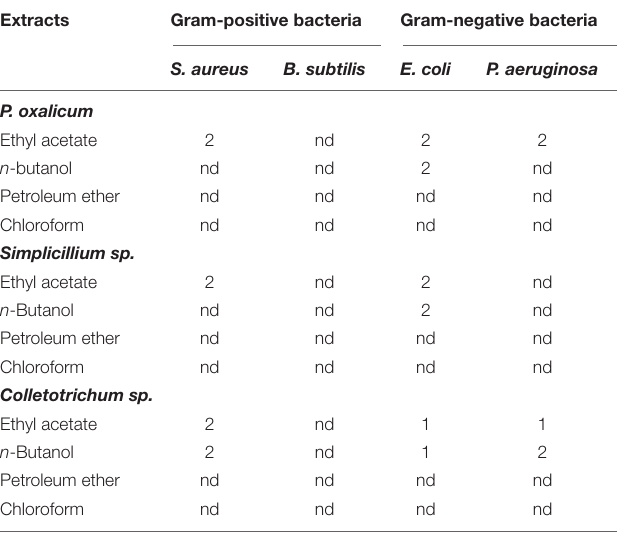
TABLE 5 | Minimum bactericidal concentration (MBC) (mg/mL) of the P . oxalicum , Simplicillium sp., and Colletotrichum sp.